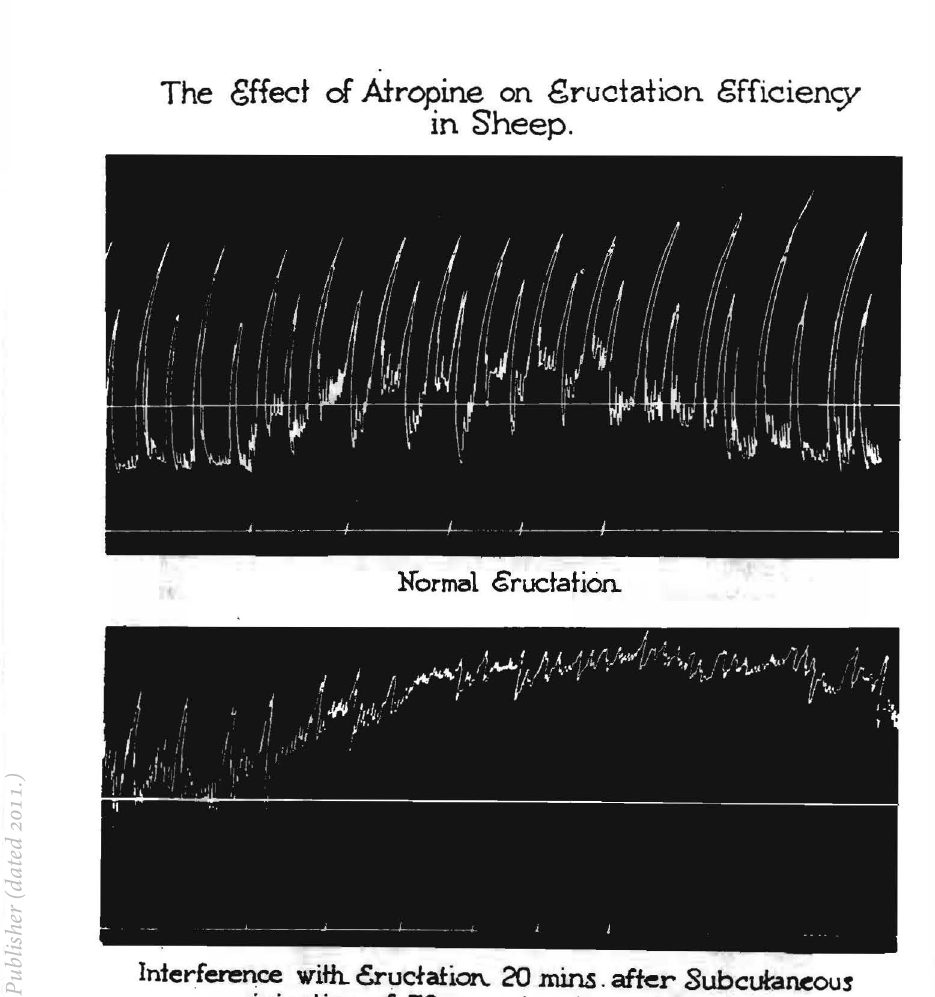
Interference with. eructation. 20 min.s . after 8ubcutancouJ ~ion of .30mgm.afropme Bulph. Fig. 15. (Weiss,